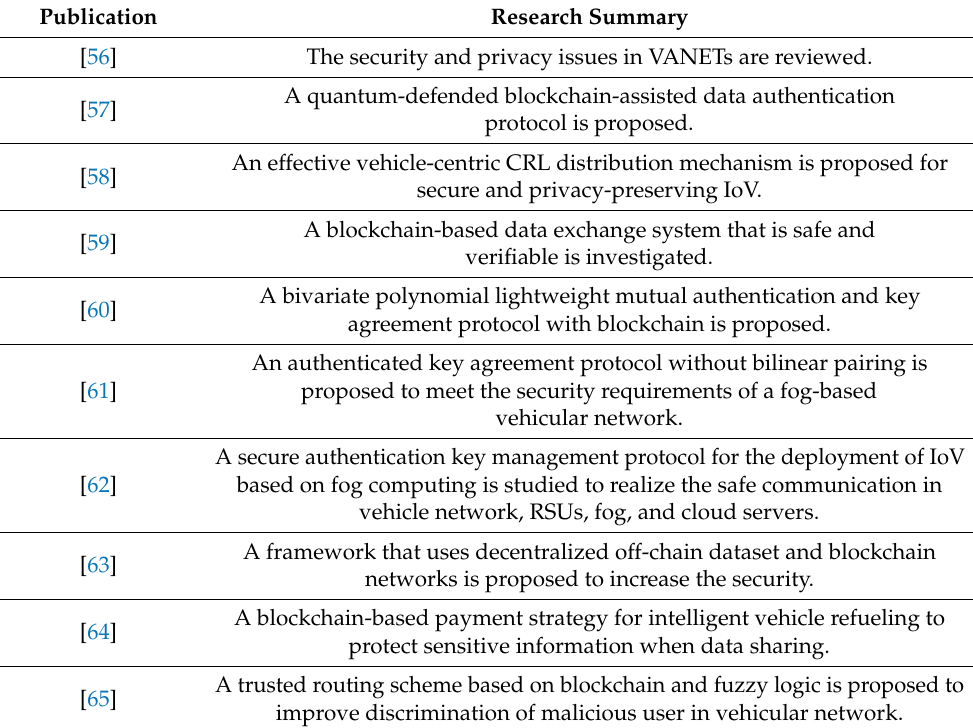
Table 3. Recent studies on Authentication and Secure Communications in